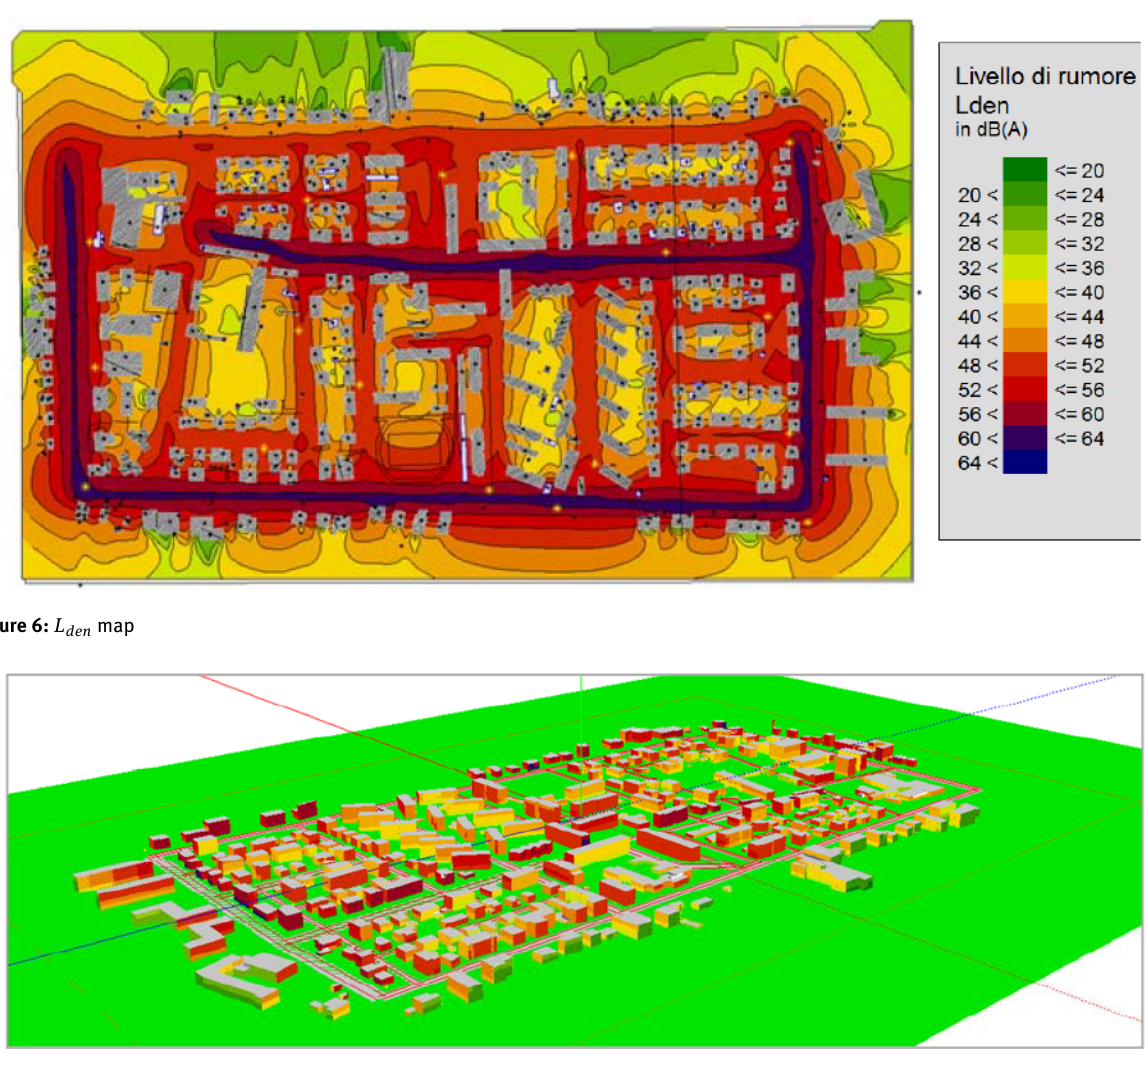
Figure 7: 3D representation of the noise distribution in the area